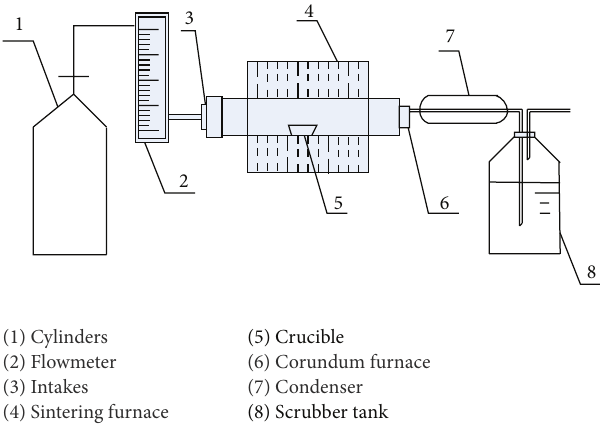
Figure 1: The structure of sintering